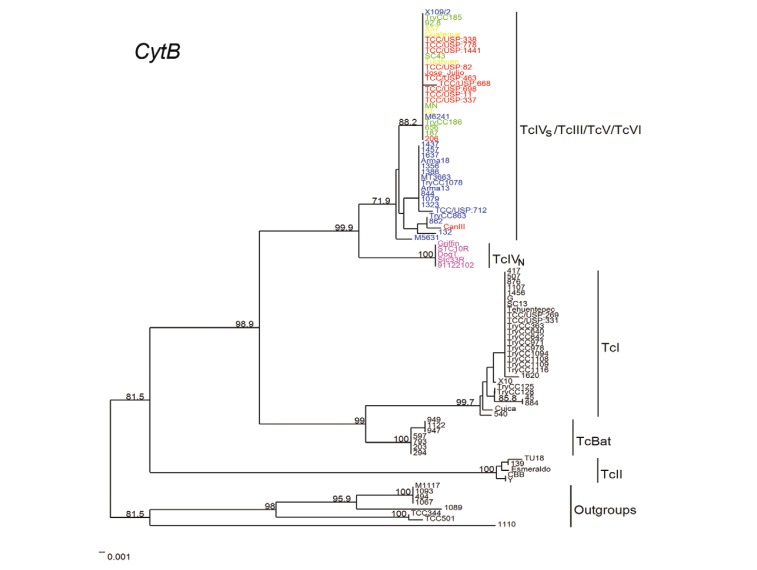
neighbour-joining tree based on cytochrome B (CytB) sequence of 97
different strains downloaded from GenBank. Branch values represent bootstrap
percentage over 1,000 replications. Different discrete typing units (DTUs) are
indicated with vertical bars (TcIVS: strains TcIV from South America; TcIVN:
strains TcIV from North America). Some sequence names were coloured to show the
corresponding DTU (blue: TcIII; red: TcIVS; violet: TcIVN; green: TcV; yellow:
TcVI).